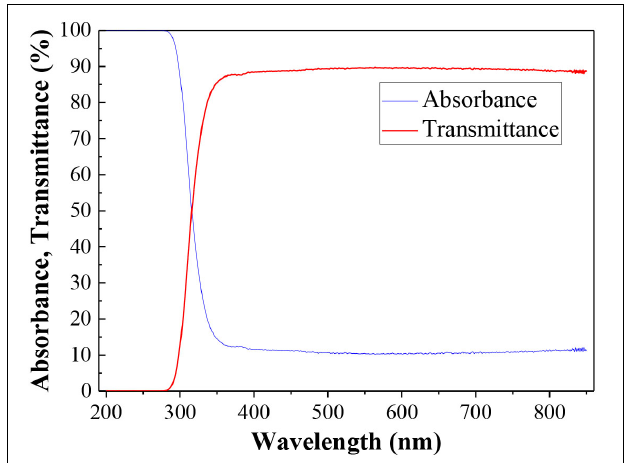
FIGURE 1 | Optical transmittance and absorbance spectra of as-deposited ITO films.